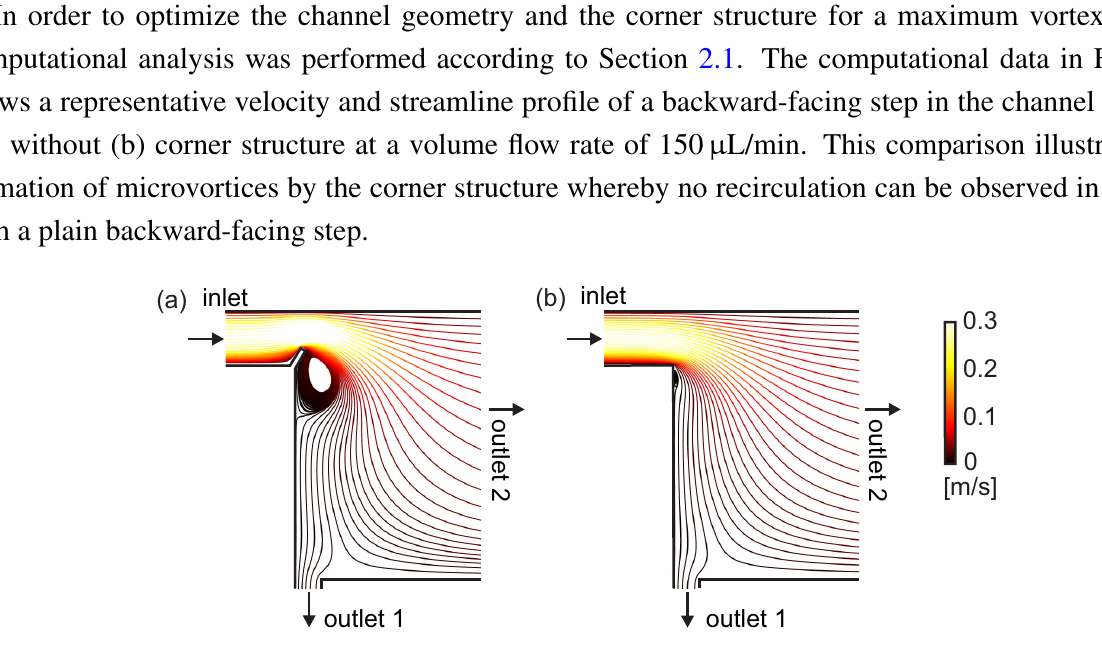
Figure 2. Velocity streamlines in a sudden expansion channel ( h = 400 µ m) with ( a ) and without ( b ) the corner structure (width × length: 10 µm × 40 µm , α = –30 ◦ ) at Re = 25. Re was calculated at the inlet channel (width × depth: 100 µm × 100 µm ) with inlet flow rate 150 µ L/min. The color of streamlines indicates the velocity magnitude